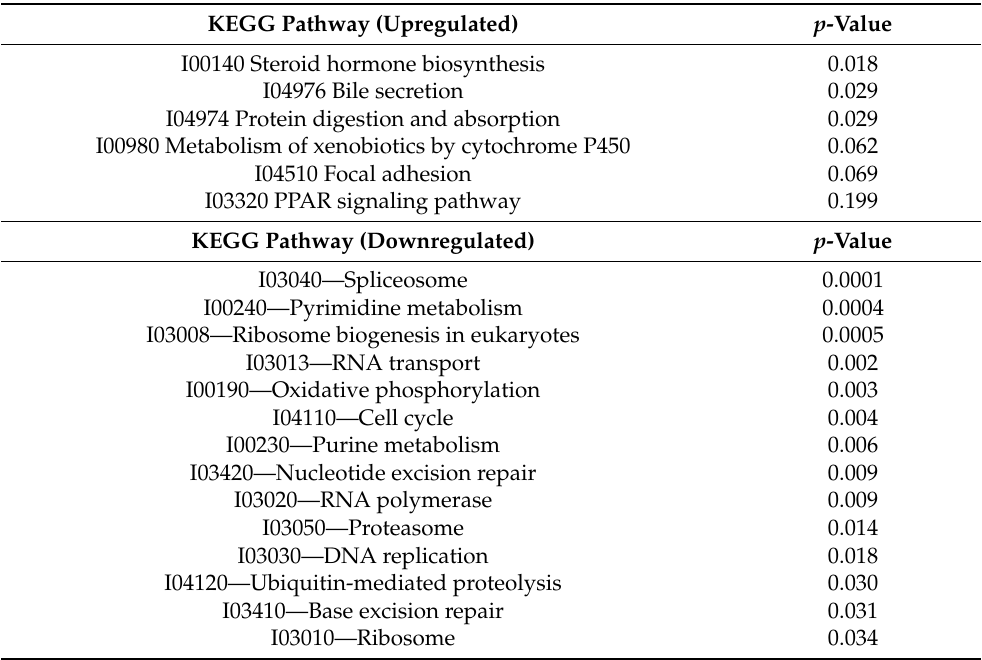
Table 1. Pathway enrichment analysis in 13-HPODE-treated Caco-2 cells. Pathway enrichment demonstrates upregulated and downregulated Kyoto Encyclopedia of Genes and Genomes (KEGG) pathways in 13-HPODE-treated Caco-2 differentiated cells relative to untreated cells. KEGG Pathway (Upregulated) p